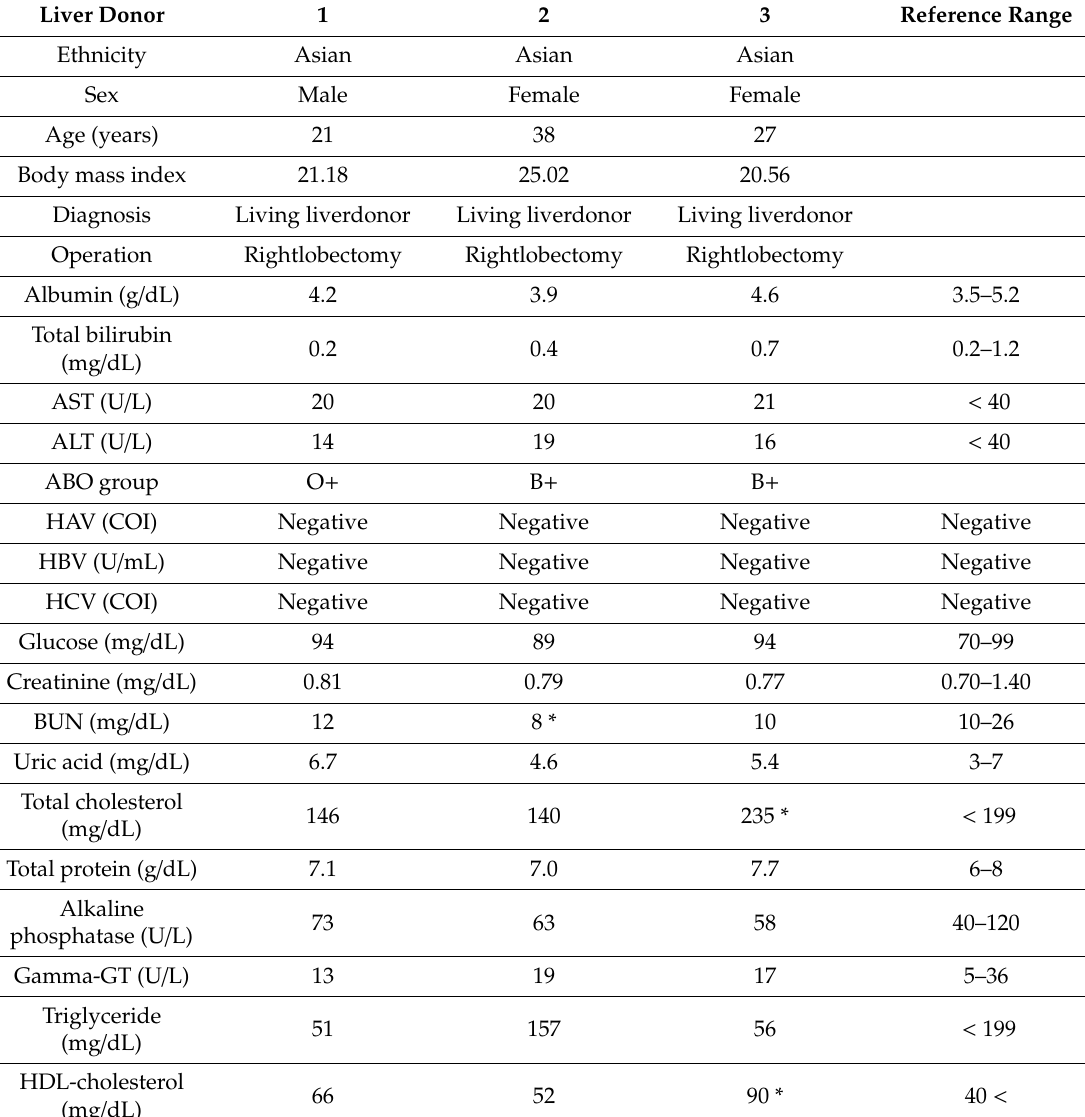
Table 1. Human liver donor